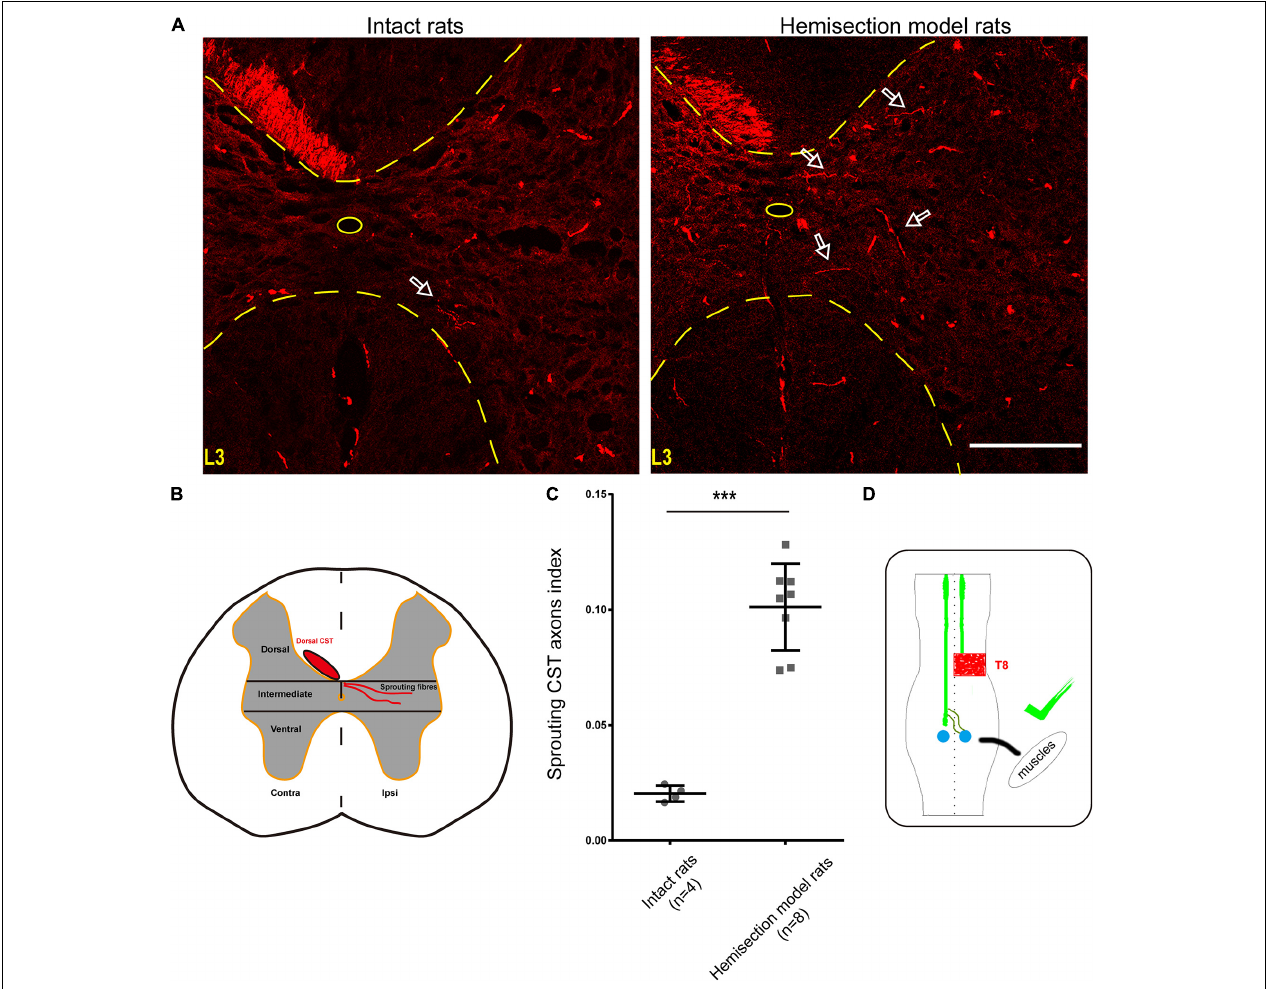
FIGURE 5 | BDA-labeled contralesional CST fibers growing toward the ipsilesional denervated gray matter of lumbar spinal cord in the hemisection model rats. (A) Representative transverse sections at the lumbar enlargement level in the hemisection model and intact rats. The BDA-labeled CST in the contralesional side germinates collateral fibers into the denervated gray matter at L3 level in the hemisection model rats; in contrast, fewer CST fibers were detected to show collateral sprouting in intact rats. The arrows indicate the axons of the lumbar spinal cord in the hemisection model and the intact rats. (B) Lumbar cord gray matter is categorized into dorsal, intermediate, and ventral parts. (C) Quantified data show a significant increase in the index of CST sprouting axons in the denervated spinal cord after hemisection injury. (D) The sketch map shows the contralesional CST axon sprouting contributing to the spontaneous locomotor recovery, confirmed in the hemisection model rats. Bars indicate mean with SD. The data are presented as the mean ± SD. *** P < 0.001. n = 8 for CST tracing in hemisection model rats; n = 4 in intact rats. Scale bar, 150 µ m. CST indicates the corticospinal tract; BDA, biotinylated dextran amine; CC, central